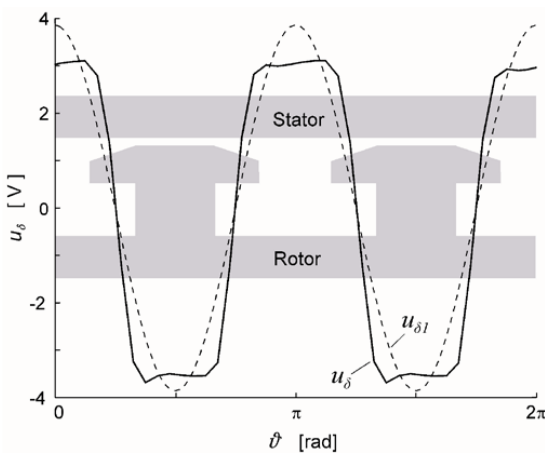
Figure 6. Signal from the air gap sensor after processing with regard to the rotor position.